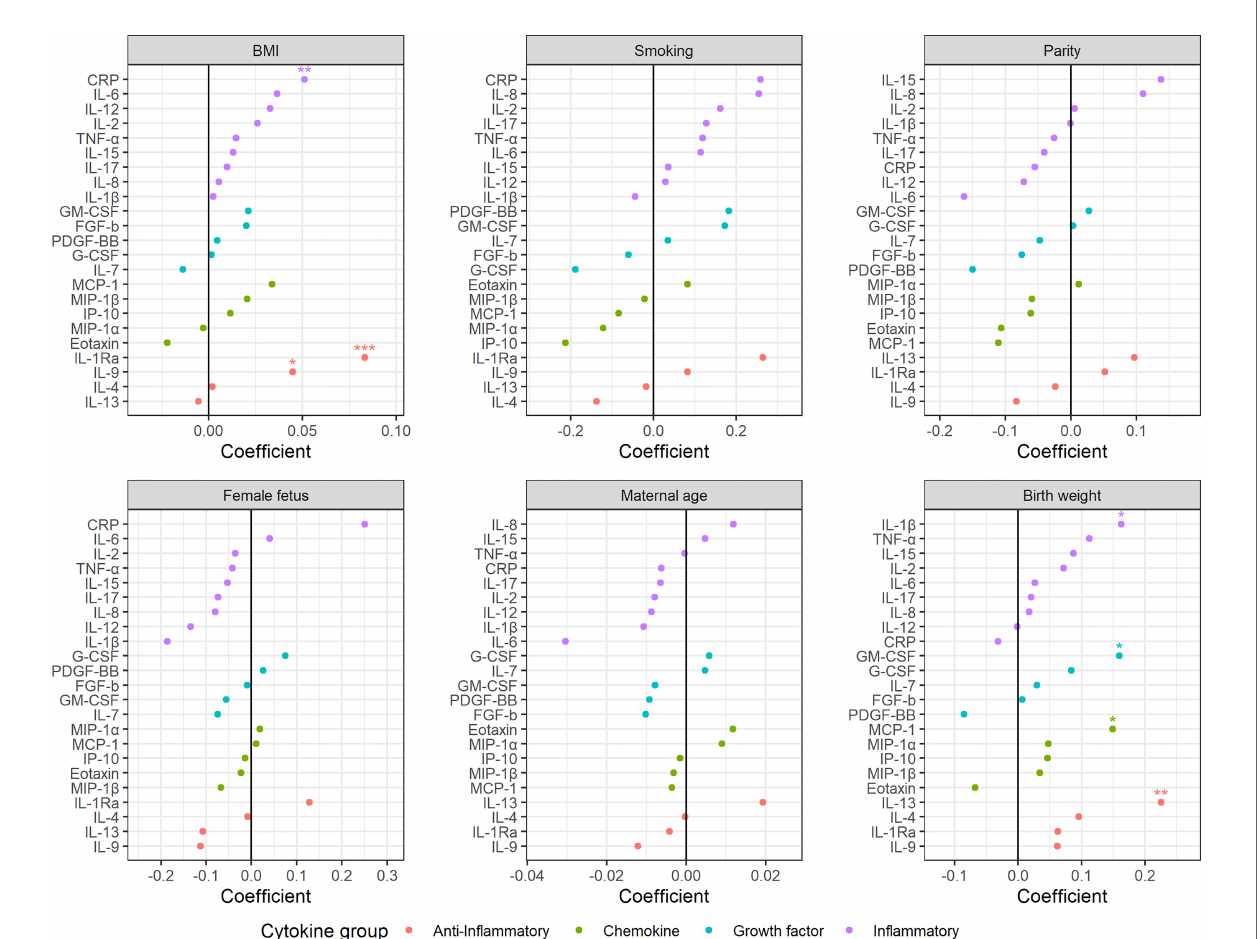
FIGURE 5 | Impact of clinical parameters on the maternal serum cytokine pro fi le beyond term. BMI, parity, maternal age, and birth weight (z-scores) are continuous variables, whereas smoking and fetal sex are categorical variables with non-smoking and female fetuses as reference, respectively. Regression coef fi cients from linear models. * P <0 .05, ** P < 0.01, *** P <